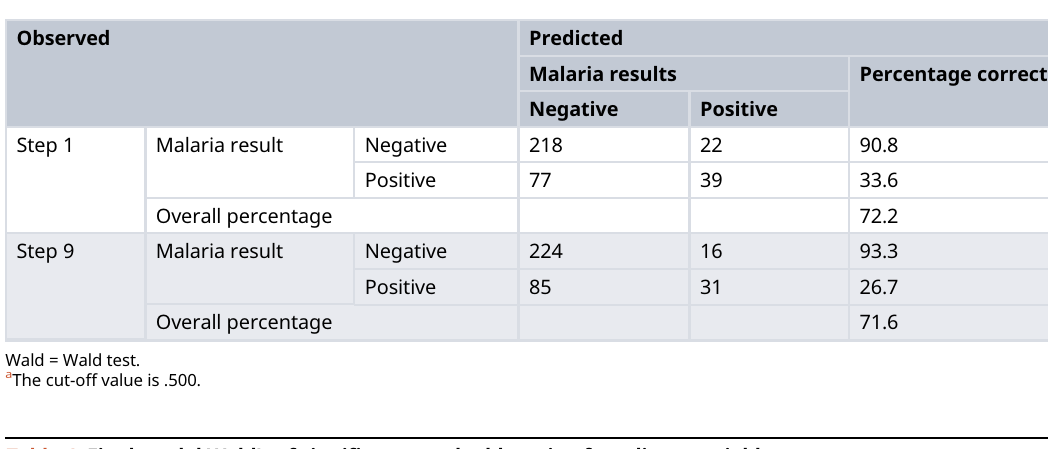
Table 4. Final model Wald ’ s of significance and odds ratio of predictor